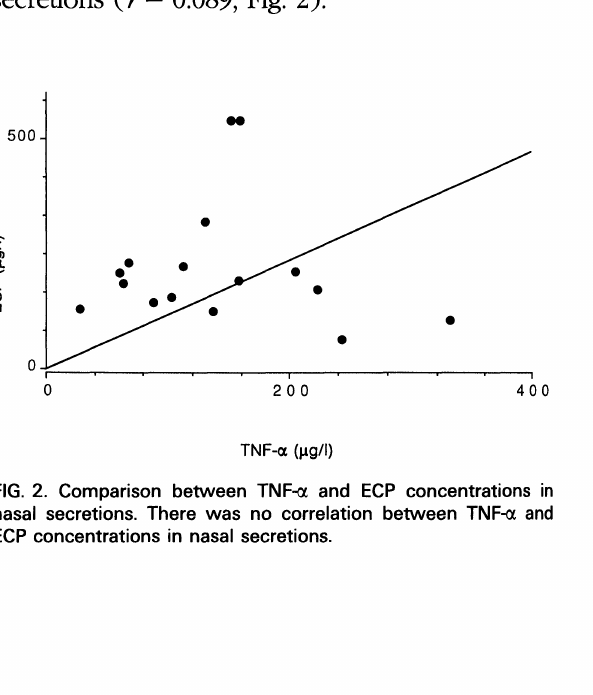
FIG. 2. Comparison between TNF- and ECP concentrations in nasal secretions. There was no correlation between TNF- and ECP concentrations in nasal